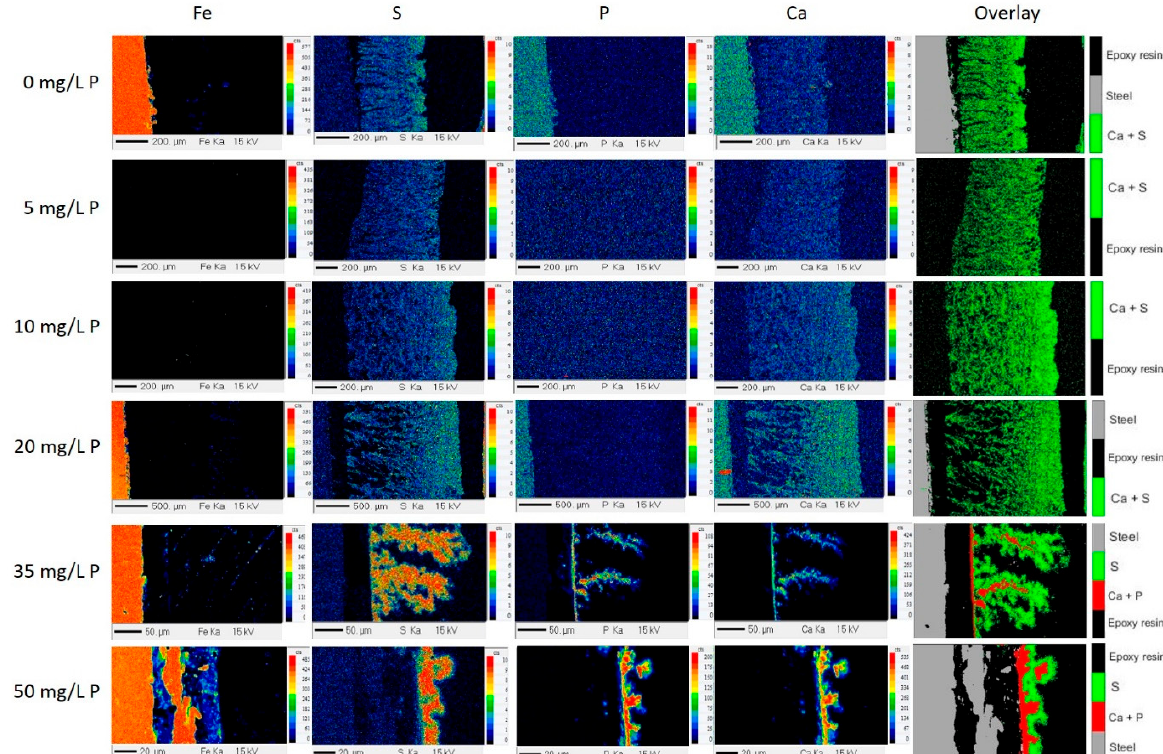
Figure 7. Fe, S, P, Ca, and the overlay X-ray mappings of the cross section of the fouling layer as a function of the added P in the WPI solutions containing 100 mg/L of Ca and 0.5% w / v of protein. For the samples 5 mg/L P and 10 mg/L P the fouling completely detached from the substrate.